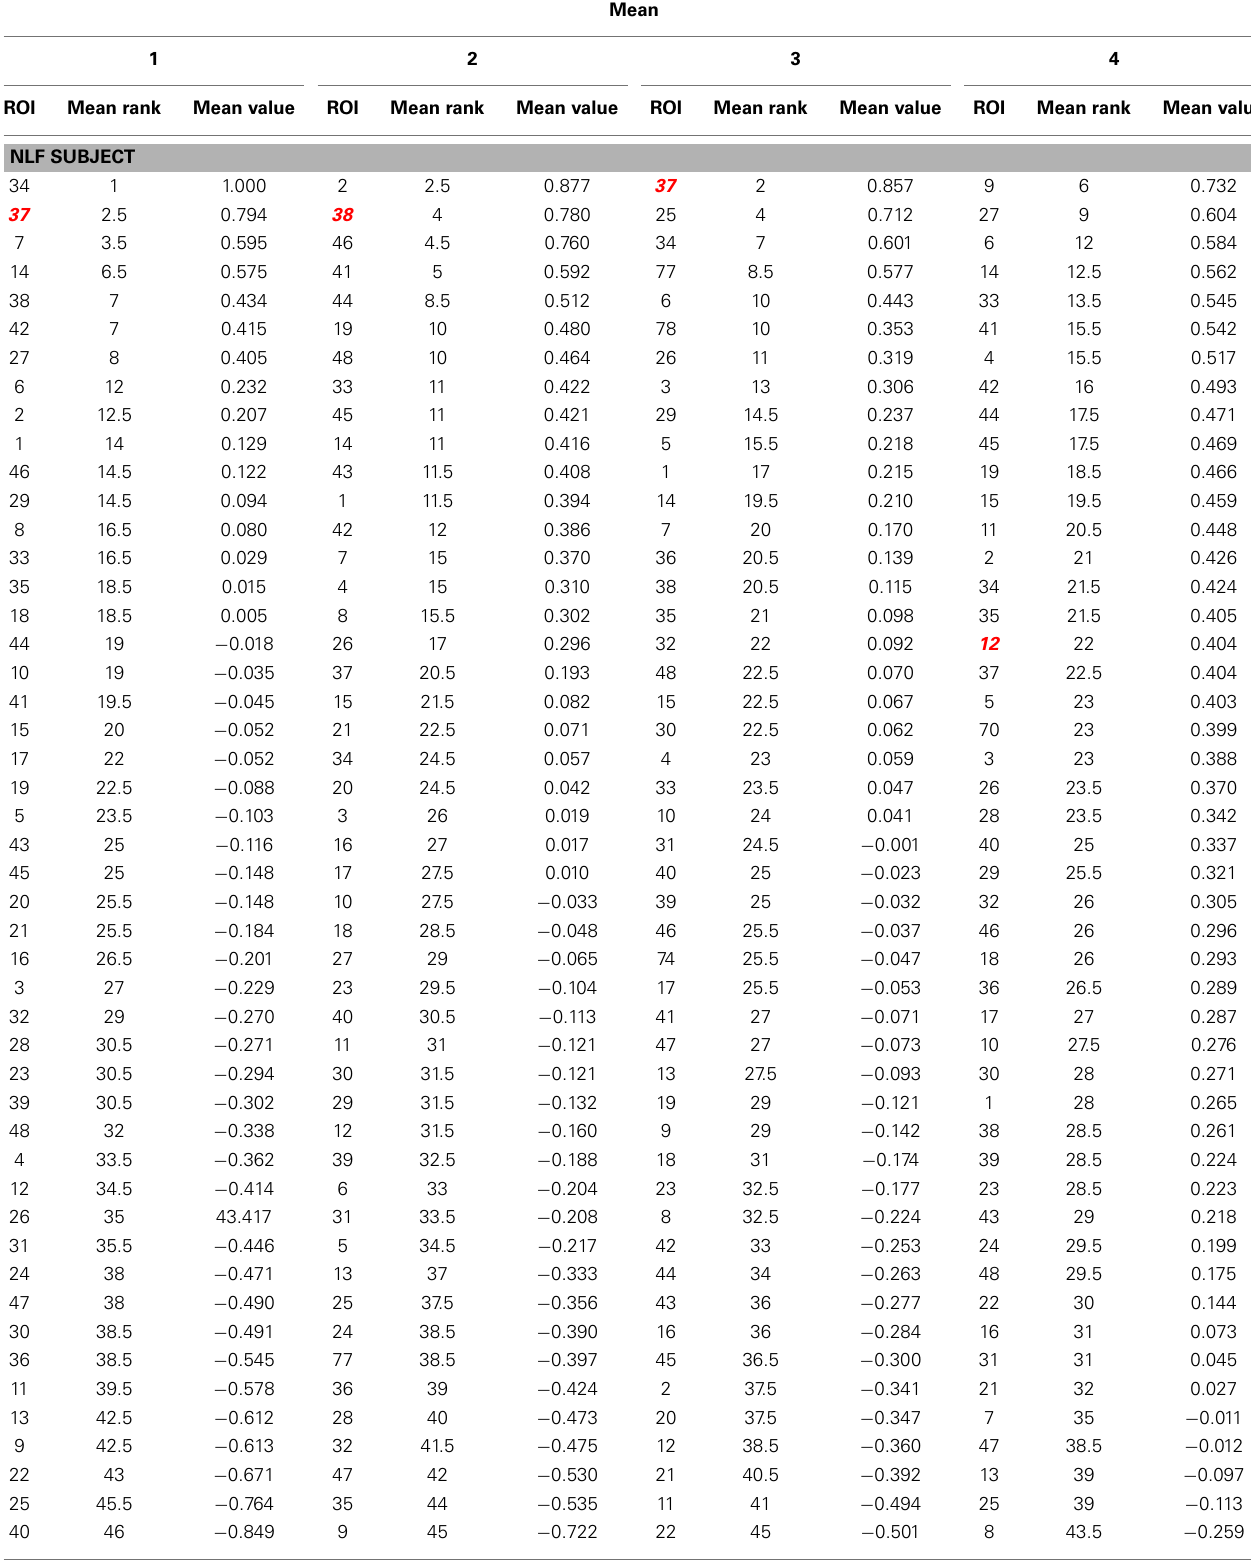
Raw values for local fc measurements with the corresponding rankings are shown across all ROIs. Red, bold text represents the seizure focus ROI for each